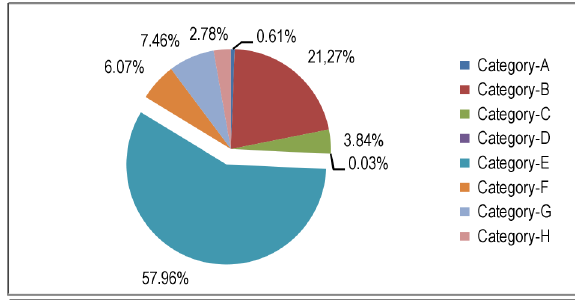
Figure 5. Proportion of patents in different areas